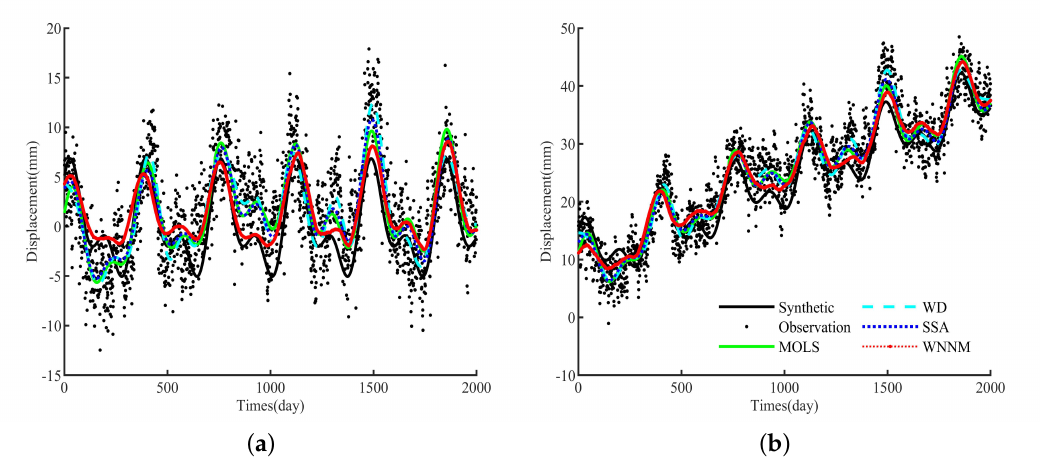
Figure 6. Comparison between extracted signal and original GNSS time series, where σ w = 1mm, σ f = 10mm/yr − k 4 . Black scatter shows GNSS observed time series, black solid line represents the simulated GNSS time series and green, cyan, blue and red lines represent signals extracted by applying MOLS, WD, SSA and WNNM, respectively. ( a ) Without trend and ( b ) with a linear